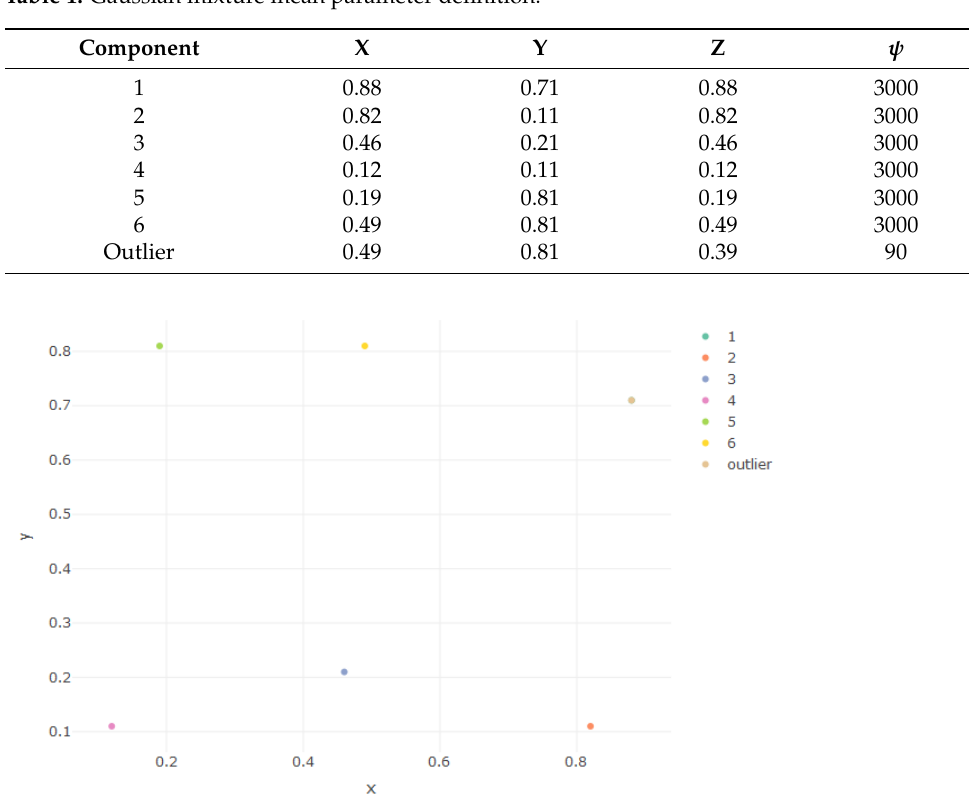
Table 1. Gaussian mixture mean parameter definition.